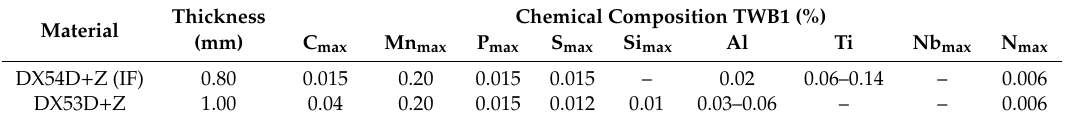
Table 1. Chemical composition and thickness of